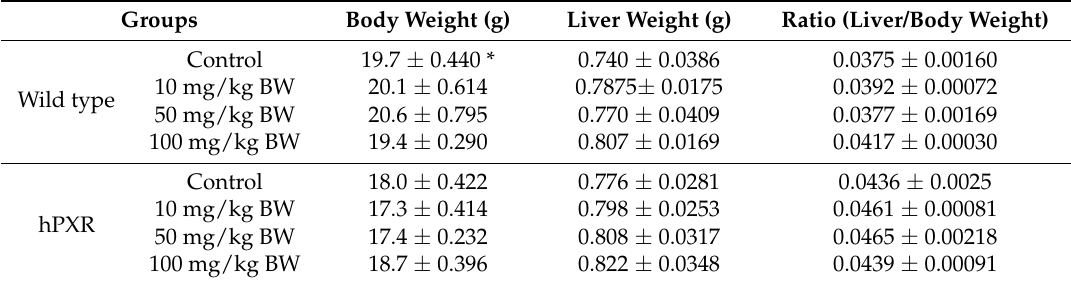
Table 2. Body and liver weights of wild type and hPXR mice treated by menaquinone-4. Groups